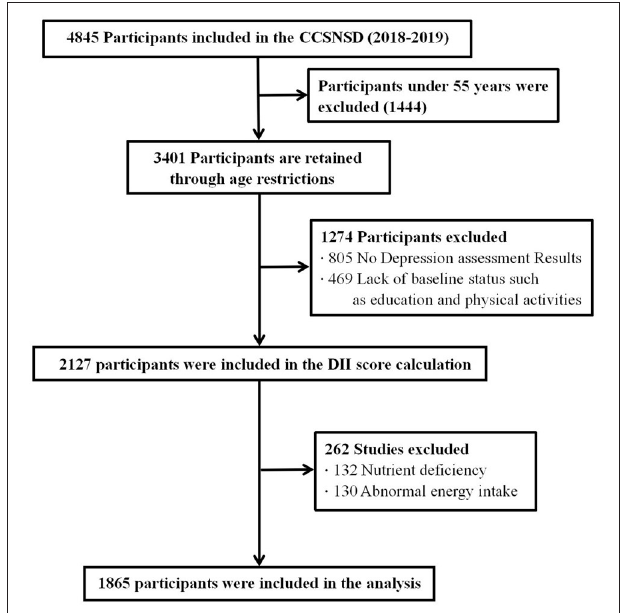
FIGURE 1 | Selection process of